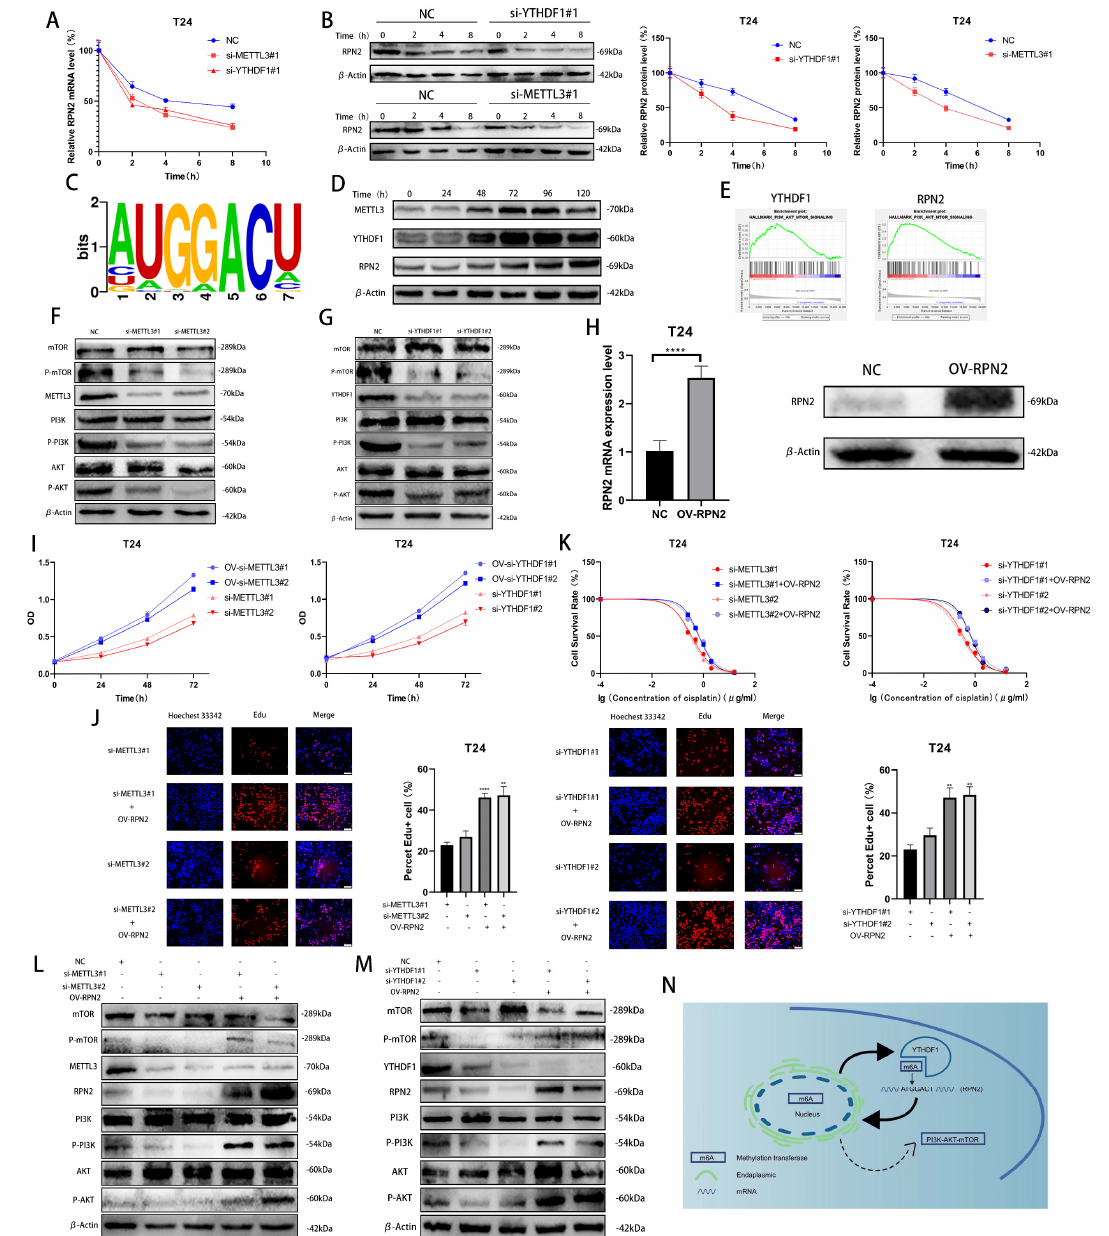
Figure 4. Validation of the METTL3/YTHDF1-RPN2-PI3K/AKT/mTOR axis in BLCA cells. ( A , B ) The effects of YTHDF1 and METTL3 on RPN2 mRNA and protein levels were verified after Dactinomycin and CHX treatment of T24 cells for 0 h, 2 h, 4 h and 8 h. ( C ) Prediction of m6A modification sites of RPN2 mRNA. ( D ) Cisplatin (0.5 μg/mL) was used to treat T24 cells for 0 h, 24 h, 48 h, 72 h, 96 h and 120 h later to verify the protein expression of METTL3, YTHDF1 and RPN2. ( E ) Single-gene Hallmark analysis found that both YTHDF1 and RPN2 were highly enriched in PI3K-AKT-MTOR SIGNALING. ( F , G ) Regulation of the PI3K/AKT/mTOR pathway by METTL3 and YTHDF1. ( H ) Overexpression of RPN2 in T24 cells. ( I , J ) CCK-8 and EdU assays verified that